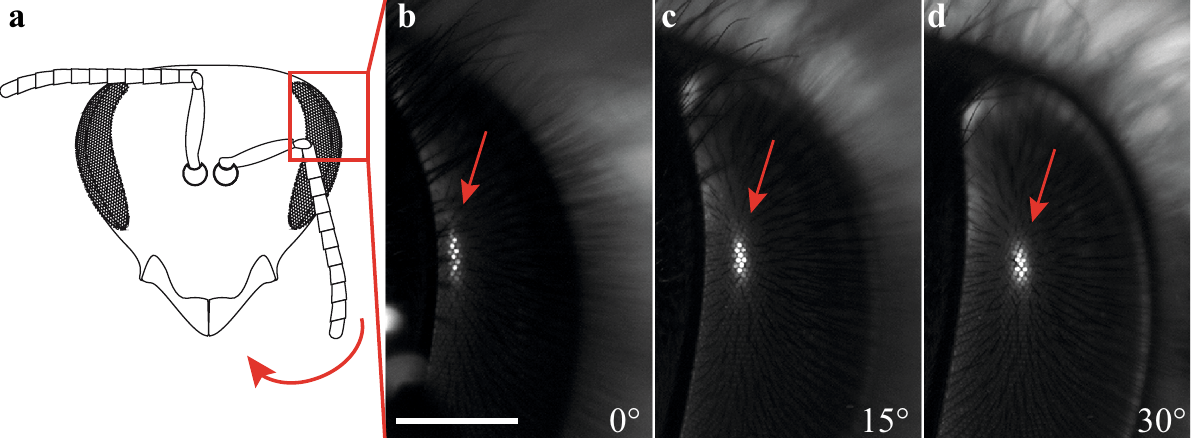
Figure 5. A induced fluorescent pseudopupil in the dark-pigmented compound eye of the honeybee, Apis mellifera . (a) The pigmented compound eye of a naive honeybee has no visible pseudopupil due to the presence of pigments around the retinula cells 61 . The red arrow shows the direction of rotation in (b–d) . (b–d) Zoomed-in view of the left eye of a honeybee forager, Apis mellifera (area of the eye as in the red inset in (a) ), acquired using a Nikon SMZ18. The eye was stained with Lucifer Yellow as described in the Methods and the bright induced fluorescent pseudopupil is thus visible ( red arrow ) and shifts its location in the eye as the head of the honeybee is turned (c, d) . (b) The head is in its frontal view and rotated around its vertical axis at 15° and 30° in (c, d) , respectively. Scale bar: 500 µm.